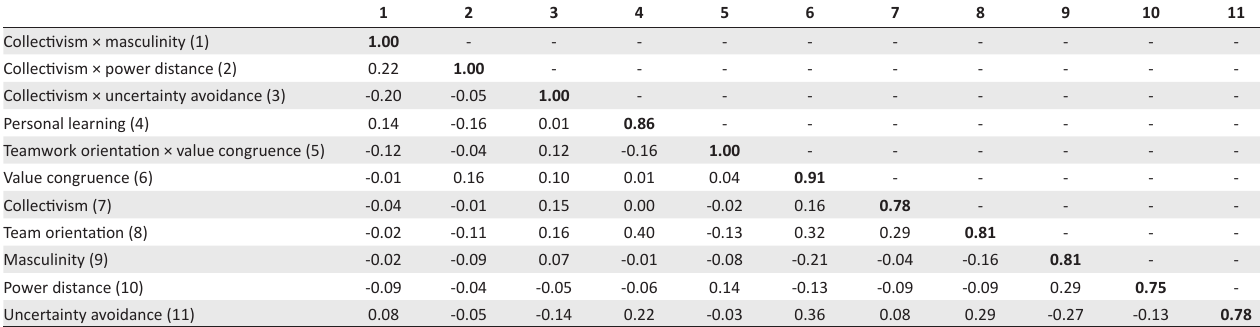
TABLE 3: Discriminant validity